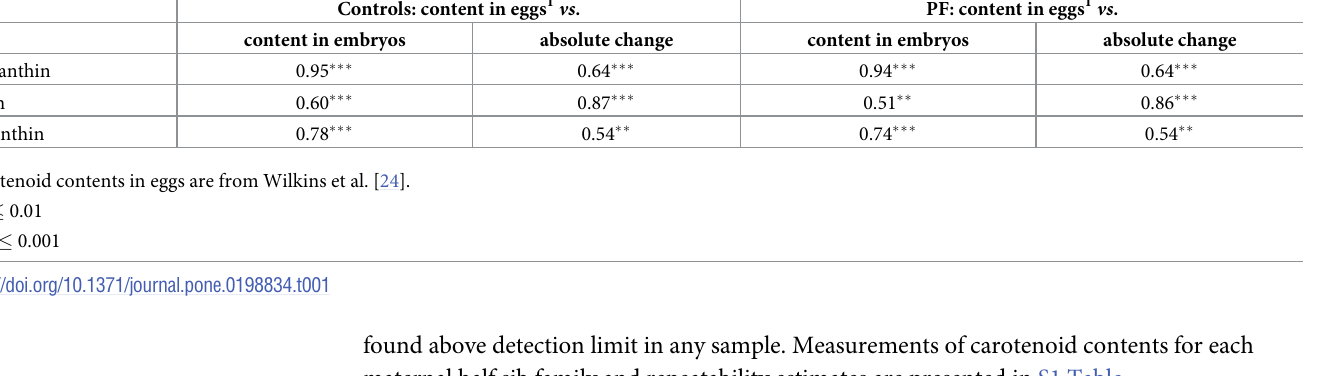
Table 1. Spearman’s rank correlation ( rho ) between carotenoid measurements in the sham-treated controls and in Pseudomonasfluorescens (PF) treated embryos. Controls: content in eggs 1 vs .